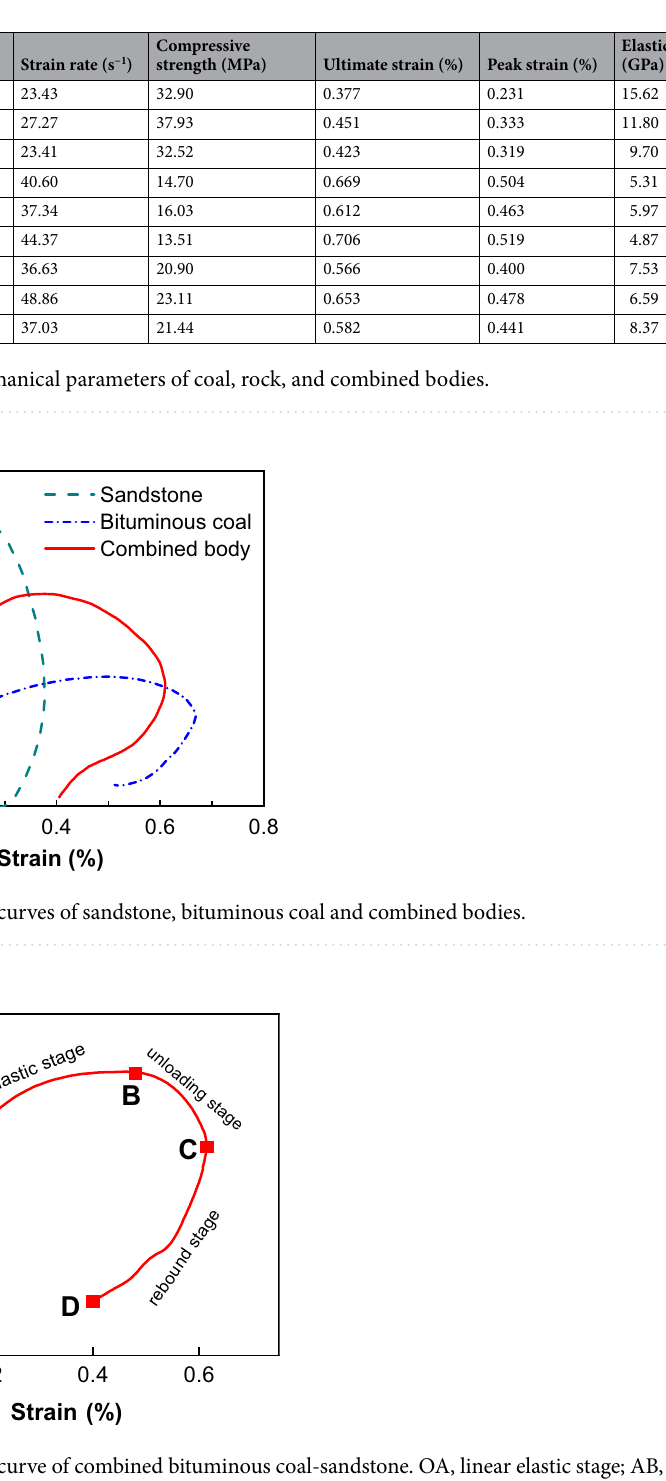
Figure 7. Stress–strain curve of combined bituminous coal-sandstone. OA, linear elastic stage; AB, inelastic stage; BC, unloading stage; CD, rebound stage. Confining pressure = 10 MPa, axial pressure = 5 MPa, striking velocity = 6